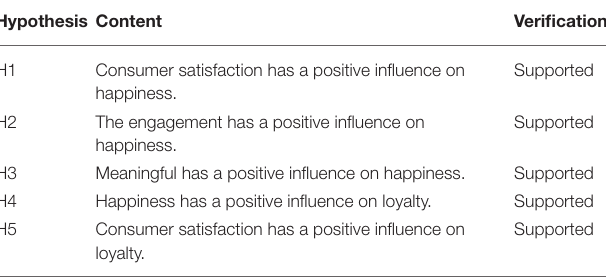
TABLE 3 | Summary of hypothesis verification.